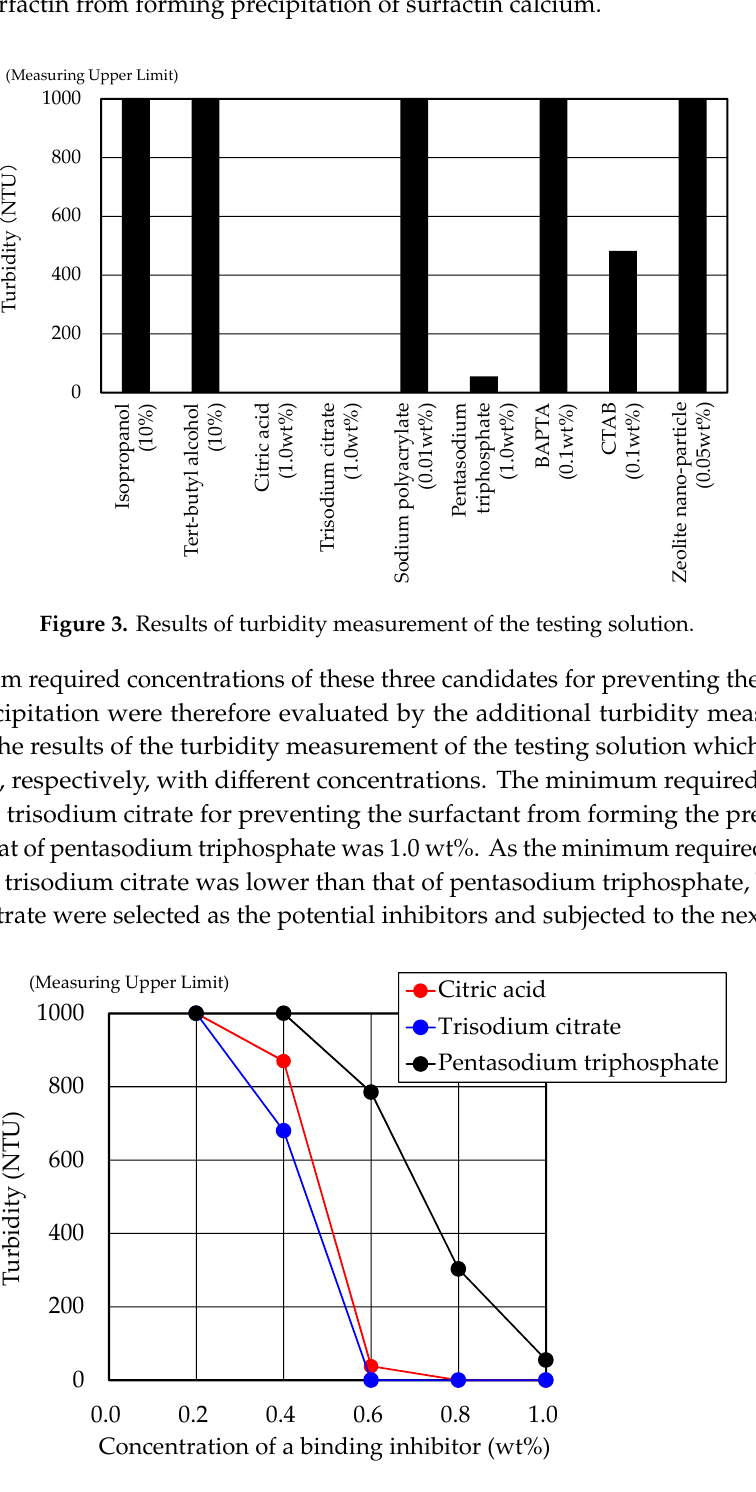
Figure 4. Relationship between the turbidity and concentration of the binding inhibitors.